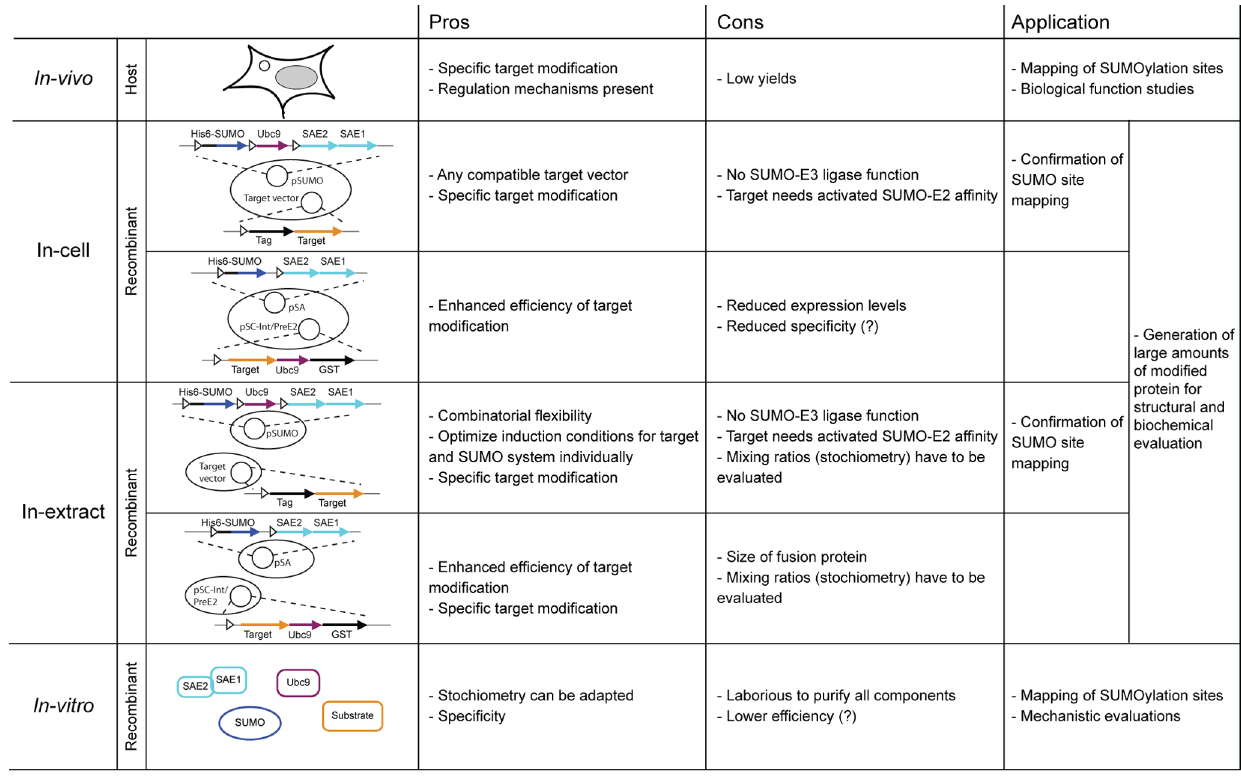
Figure 6. Summarizing table. Overview on our newly introduced SUMOylation systems indicating advantages, disadvantages and putative applications in comparison to host in vivo and purely in vitro systems.